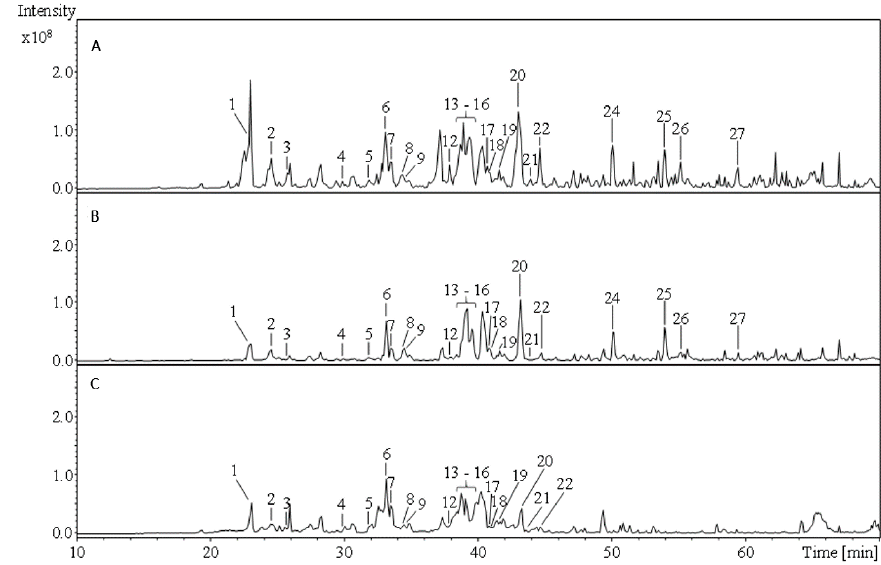
Figure 2. Comparison of total ion chromatograms (TIC) of the Achillea millefolium acetone/water extract ( A ) and the Achillea millefolium ethyl acetate ( B ) and n -butanol ( C ) fractions. 1: chlorogenic acid; 2: p -coumaroyl acid derivative; 3: apigenin- 6,8-di- C -hexoside; 4: quercetin- O -hexoside I; 5: 4-methyl-3-methoxy-9a-hydroxyligballinol- O -glucoside (formate adduct); 6: quercetin-3- O -rutinoside;